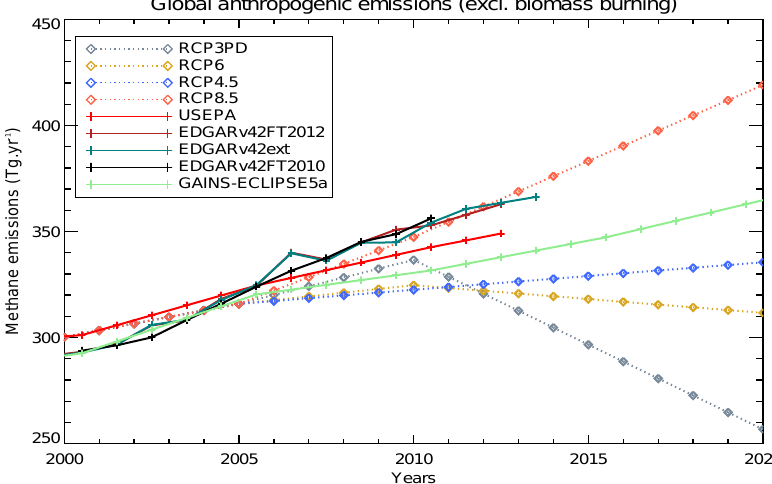
Figure 2. Global anthropogenic methane emissions (excluding biomass burning) from historical inventories and future projections (in TgCH 4 yr − 1 ). USEPA and GAINS estimates have been linearly interpolated from the 10- or 5-year original products to yearly values. After 2005, USEPA original estimates are